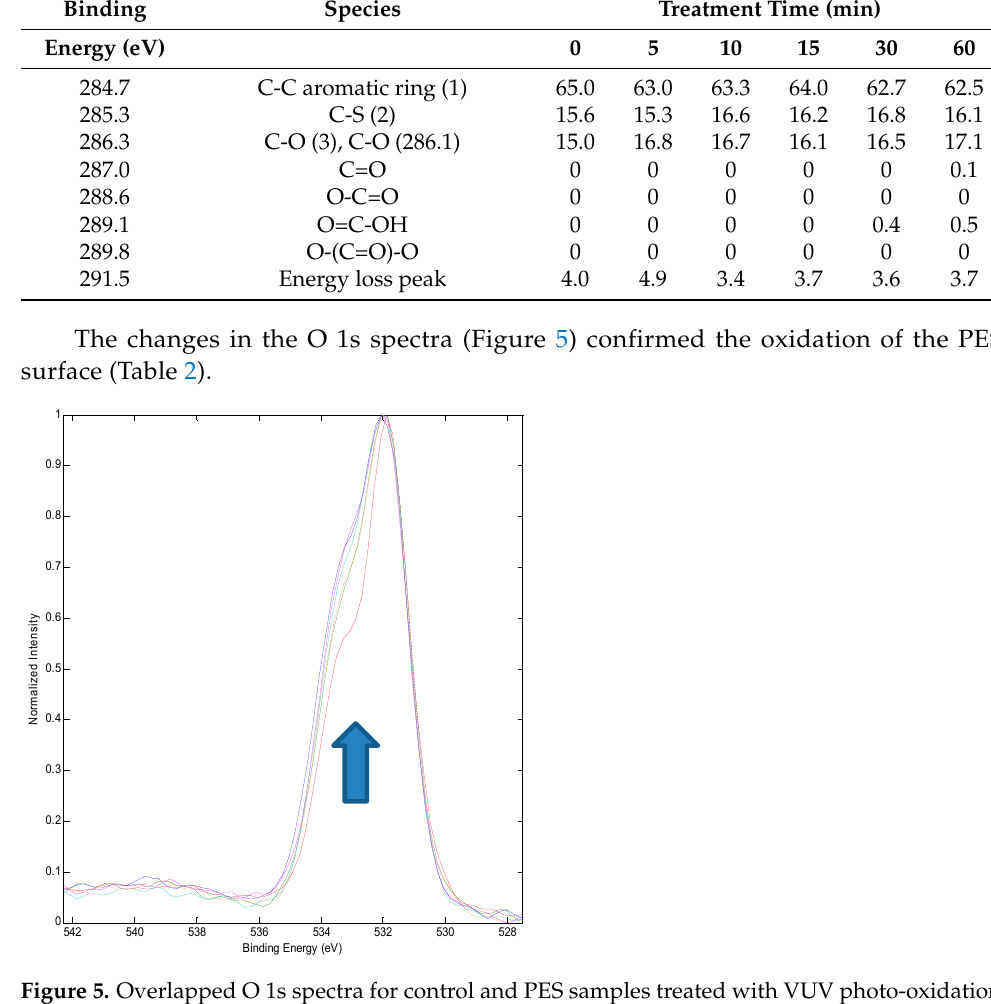
Figure 5. Overlapped O 1s spectra for control and PES samples treated with VUV photo-oxidation. The arrow indicates increasing treatment time for 0, 5, 10, 15, 30, and 60 min. Table 2. Assignments [15] and % areas for O 1s peaks in Figure 5 as determined by curve-fitting for the oxygen atoms (1) and (2) in Figure 1. The * indicates the O atom assigned to that binding energy. Binding